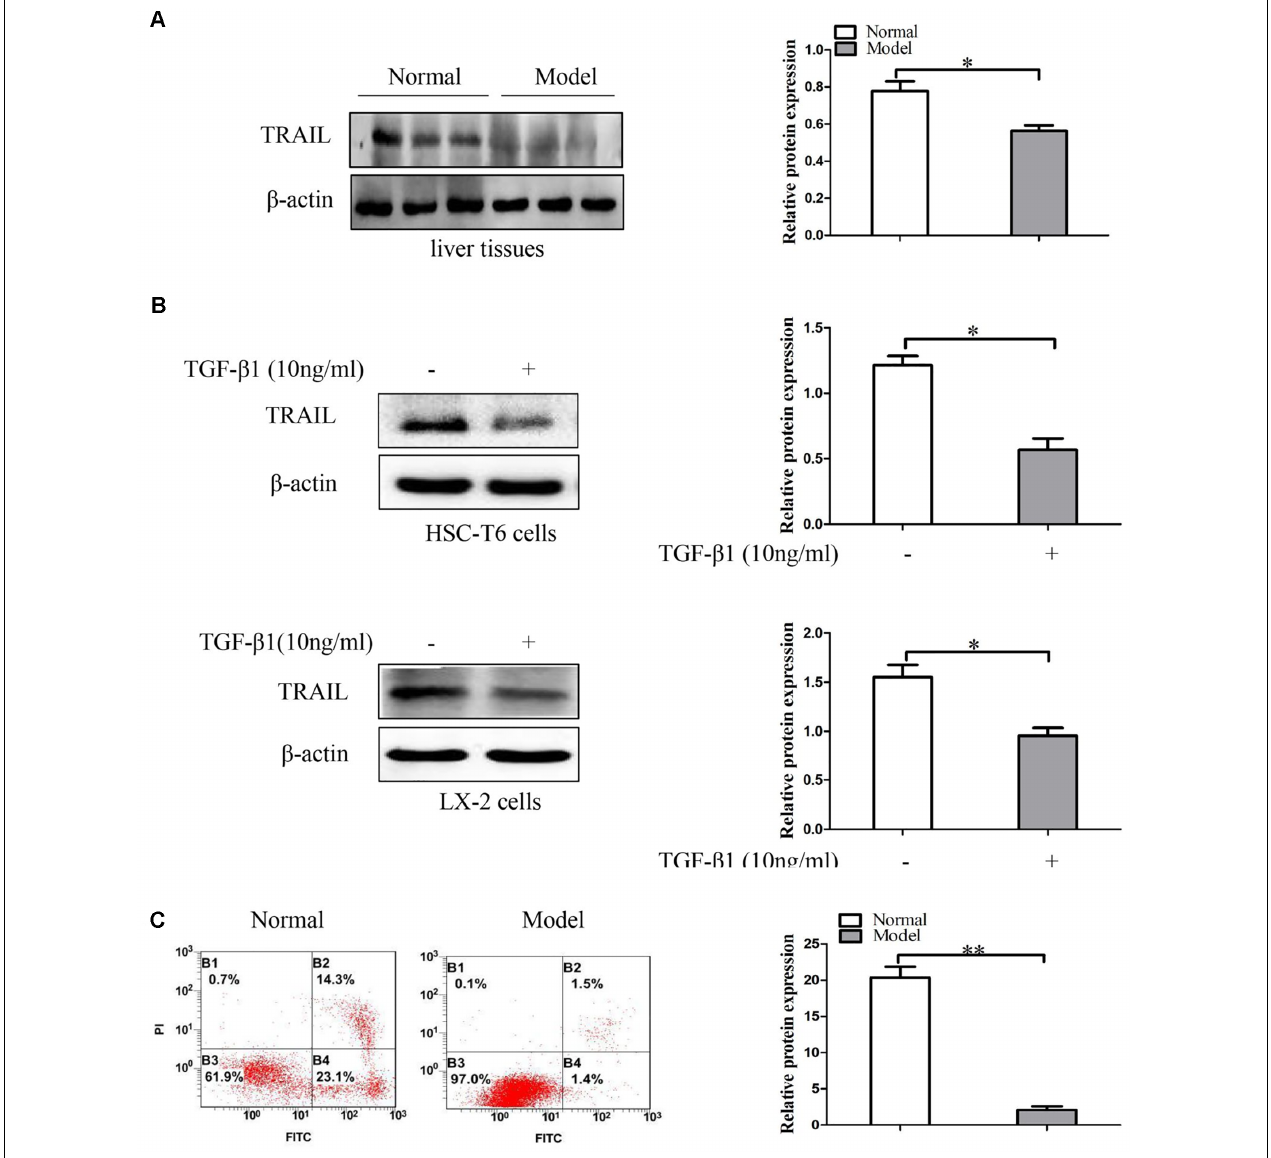
FIGURE 2 | The expression of TRAIL in liver fibrosis tissues and TGF- β 1-treated HSCs. (A) Western blot analysis and quantitative data for TRAIL expression in liver fibrosis tissues, β -actin as the loading control. (B) Western blot analysis and quantitative data show TRAIL expression in HSC-T6 cells and LX-2 cells treated with TGF- β 1 (10 ng/ml) for 24 h. (C) The apoptotic rate of primary HSCs were determine by flow cytometry. The assays were performed at least three times with similar results. Data are shown as the mean ± SD ( n = 3) of one representative experiment. ∗ p < 0.05, ∗∗ p < 0.01 versus normal